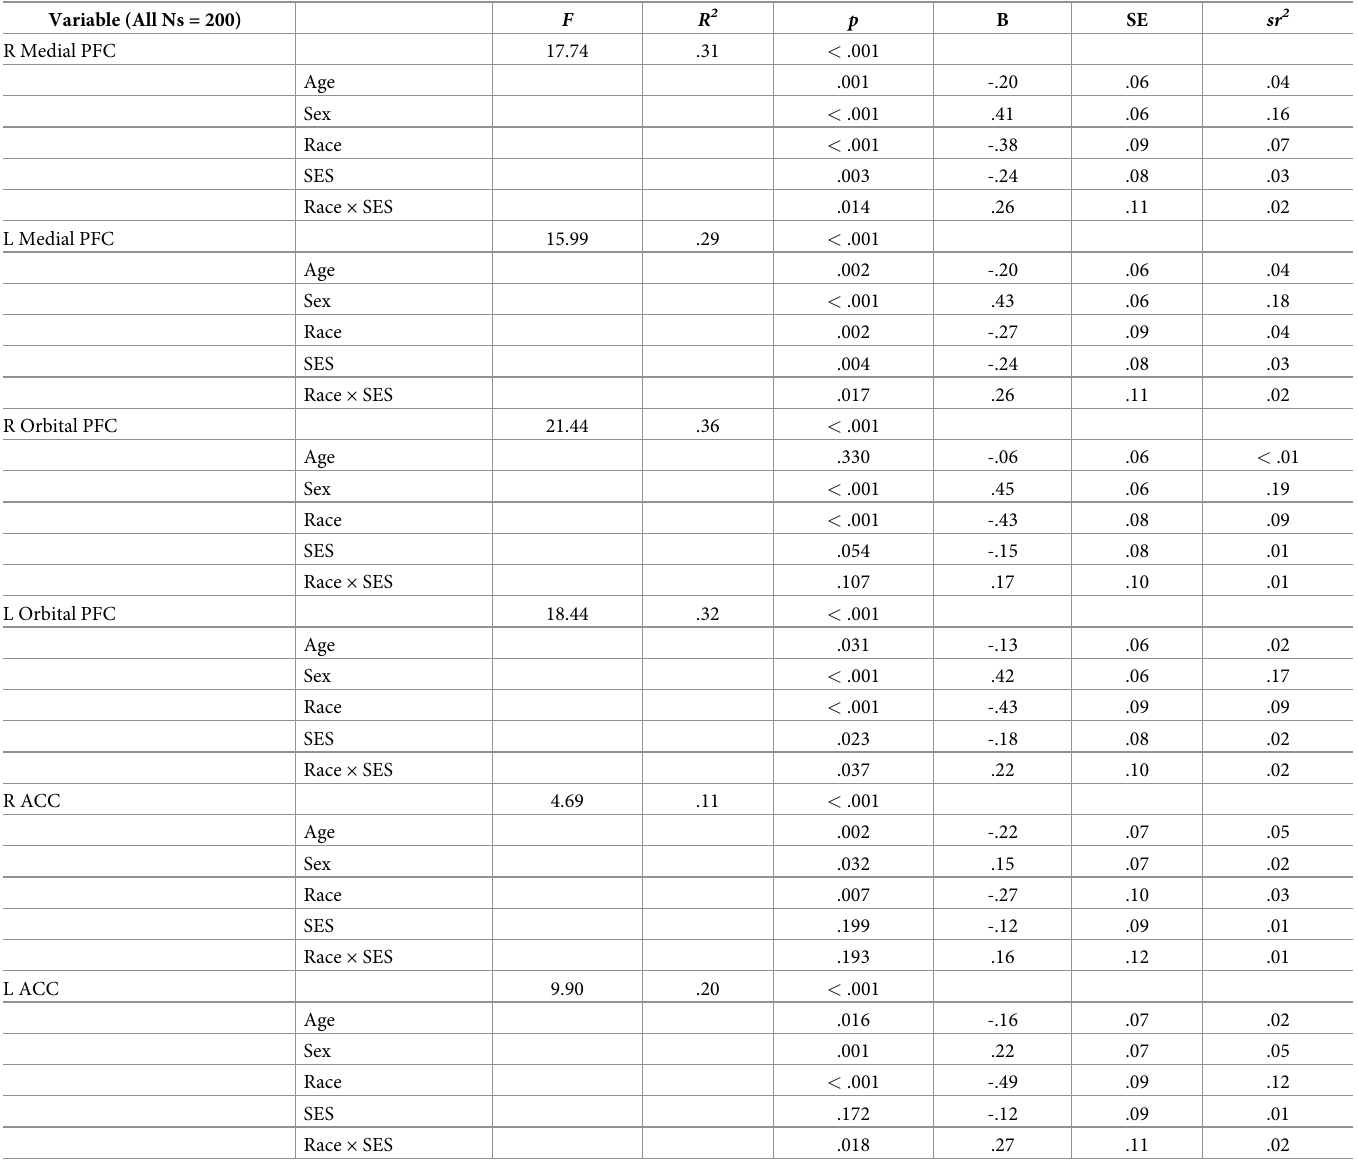
R = Right; L = Left; PFC = prefrontal cortex; ACC = anterior cingulate cortex; B = standardized regression coefficients; SE = standard error; sr 2 = semipartial correlation